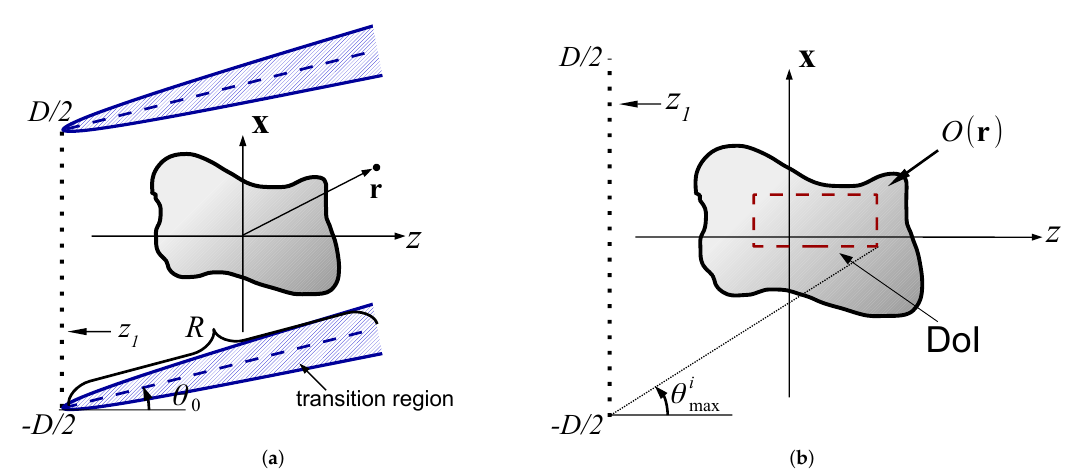
Figure 5. Guidelines for choosing the experimental setup. ( a ) The size of the array should be wide enough to provide a plane-wave illumination at the target range R . The scan angle is limited in order to be sufficiently far for the end-point diffraction zone. ( b ) For local imaging, only the part of the object inside the DOI should satisfy the conditions